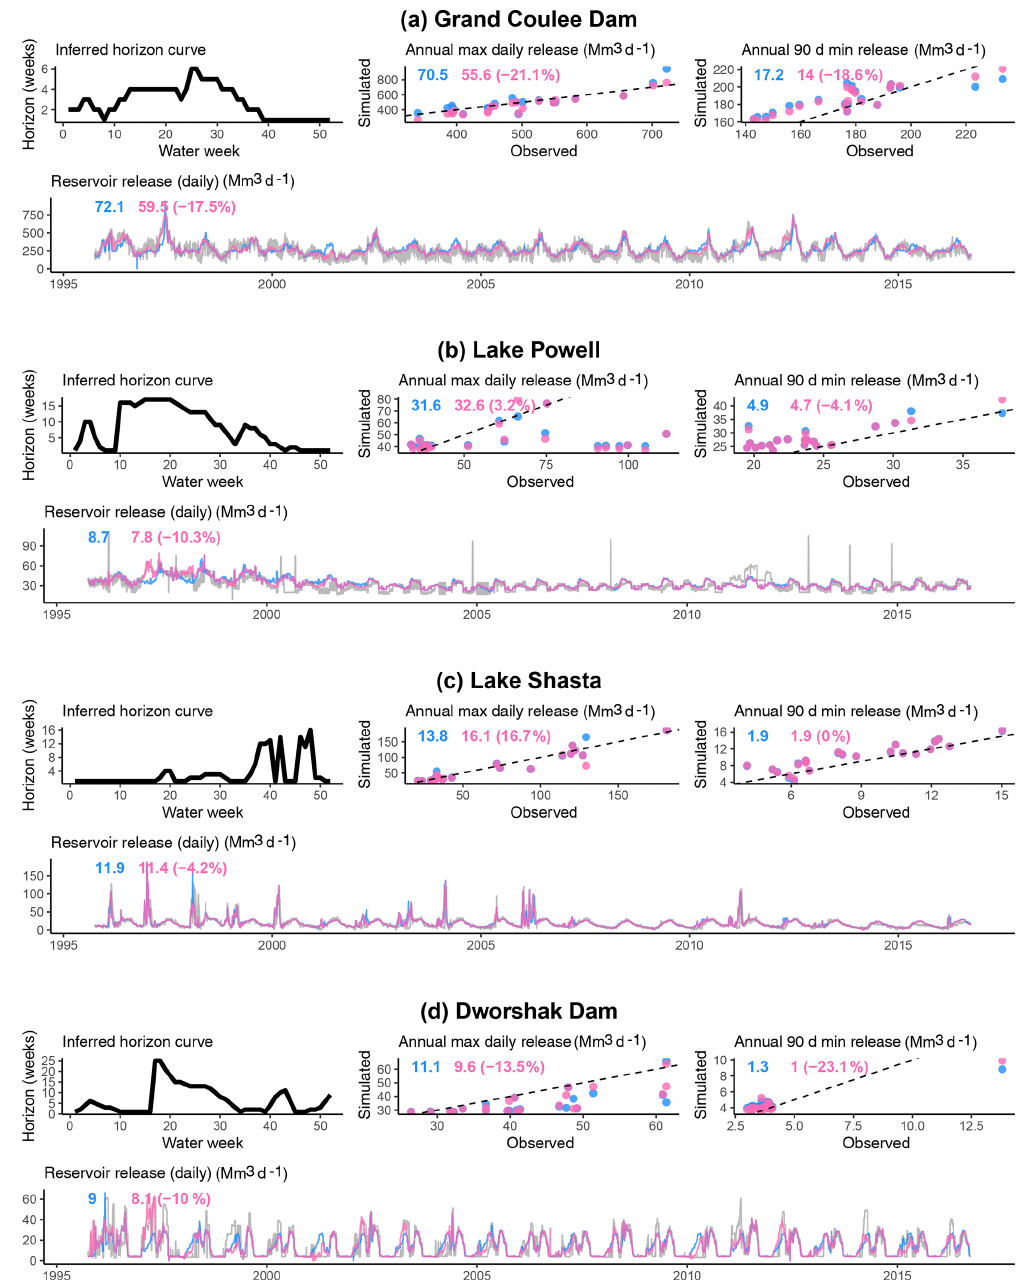
Figure 8. Simulation performance improvements with the horizon curves adopted. Blue represents the forecast excluded; pink represents the forecast included. Results given for four large storage dams, showing the inferred horizon curve, scatter plots for annual maxima and annual minima (90d average) releases (representing performance during flood and drought conditions, respectively) and the daily release time series. Numbers inside plot panels give RMSE scores relative to the observation (percent difference with the horizon curve in